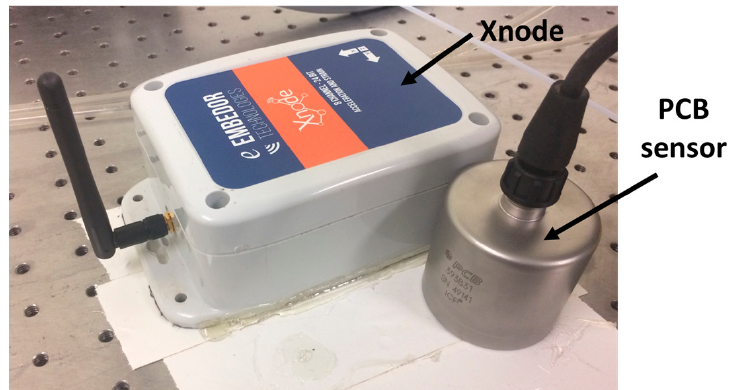
Figure 14. Ambient vibration test in an optical table.